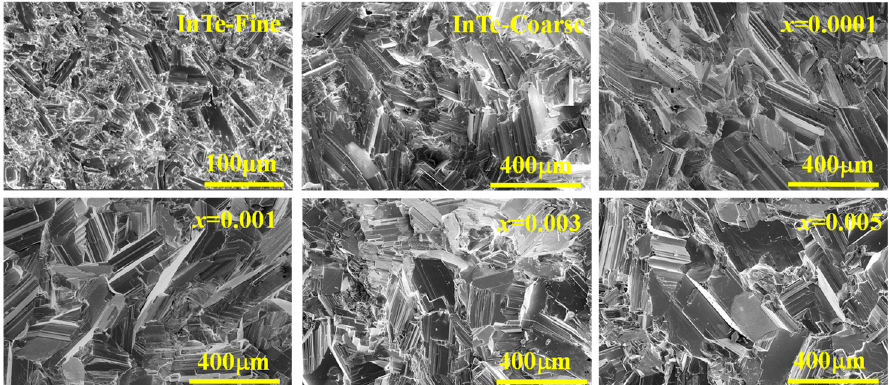
Figure 2. Cross-section SEM images for the sieved fine InTe and coarse In 1- x Pb x Te ( x = 0, 0.0001, 0.001, 0.003, 0.005). 0.003,